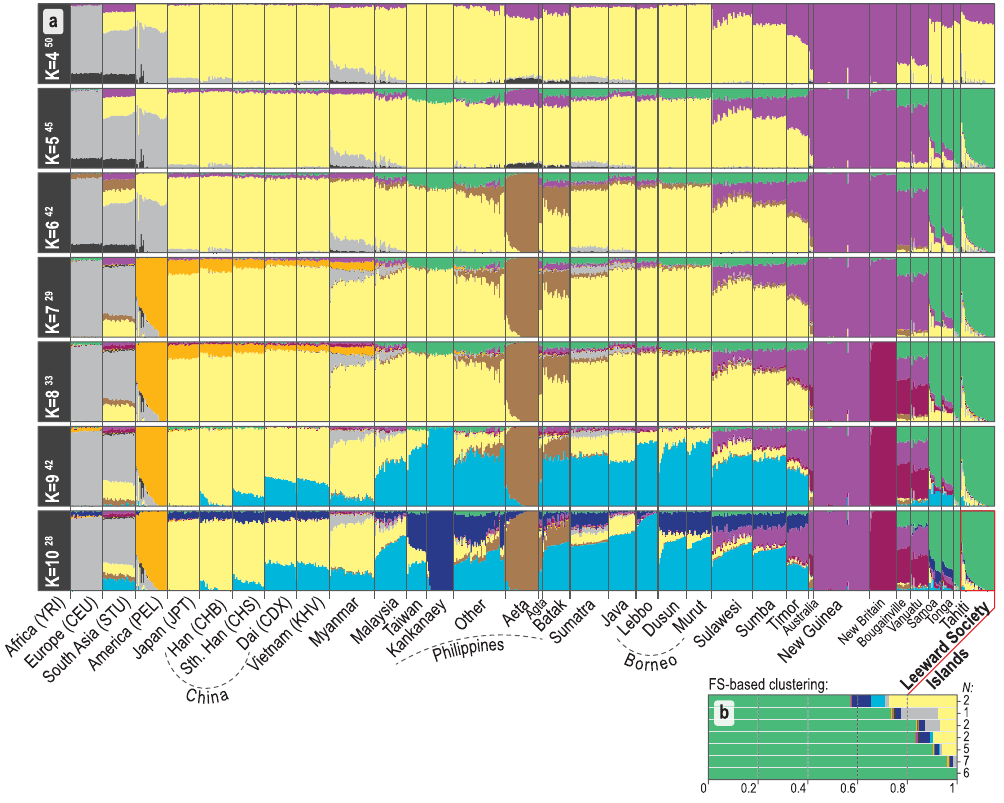
Figure 2. Ancestral genomic components in study populations estimated using ADMIXTURE. Details of the populations are provided in Supplementary Table S1B. The colors used have been selected to be equivalent to those used in Fig. 1. Only runs from K = 4 to 10 are shown, complete results ( K = 2 to 15) are given in Supplementary Fig. S1. ( a ) For every value of K, the modal solution with the highest number (superscript) of ADMIXTURE 35 runs is shown; individual ancestry proportions were averaged across all runs and the average cross-validation statistics were calculated across all runs from the same mode (Supplementary Fig. S2). The minimum cross-validation score is observed at K = 11 but no further components appear in the profiles of Polynesians after K = 10. Populations from the Philippines can be generally divided into Negritos (Aeta, Agta and Batak), Kankanaey of northwestern Luzon, and all others representing an amalgamation of groups from Luzon, Palawan and Visayas (see Fig. 1 and Supplementary Table S1B). ( b ) The average of K = 10 ADMIXTURE profiles for groups of Leeward Society individuals clustered by fineSTRUCTURE 37 (Supplementary Fig. S6), indicating the heterogeneous distribution of East Asian and European ancestry among the Leeward Society